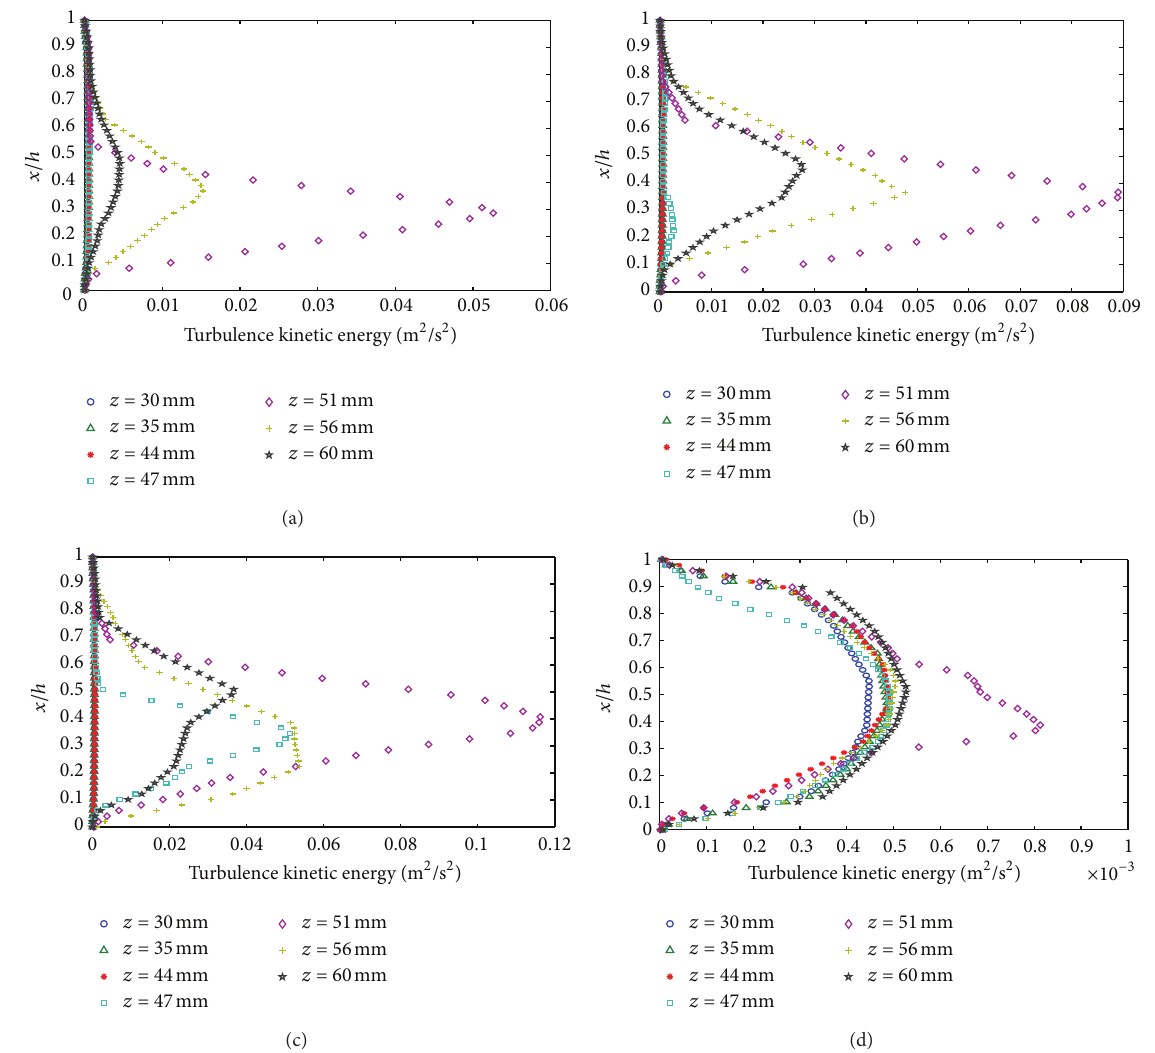
Figure 9: Turbulence kinetic energy profiles plotted against wall-normal distance scaled by lumen height ( ℎ ) at different axial positions along the length of the artery during peak systole ( 𝑄 max ) for (a) Type I, (b) Type II, (c) Type III, and (d) Type